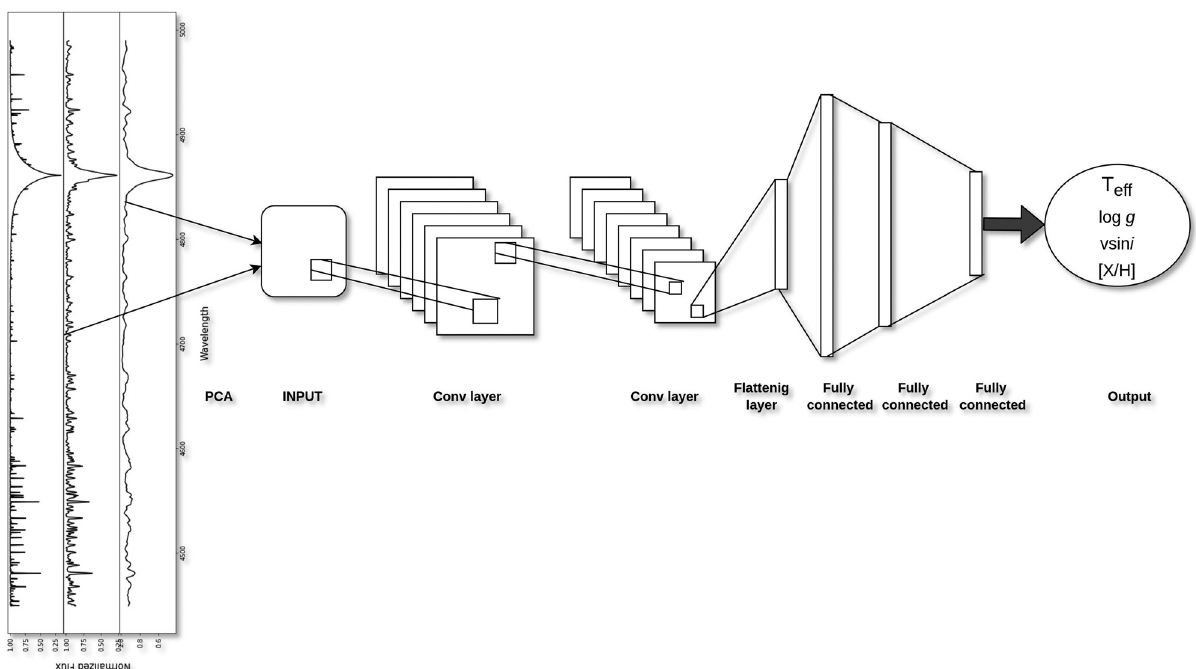
Figure 3: CNN architecture used in this work. A PCA dimension reduction transforms the spectra into a matrix of input coe ffi cient. This input passes through several convolutional layers and fully connected layers in order to train the data and predict the stellar parameters.